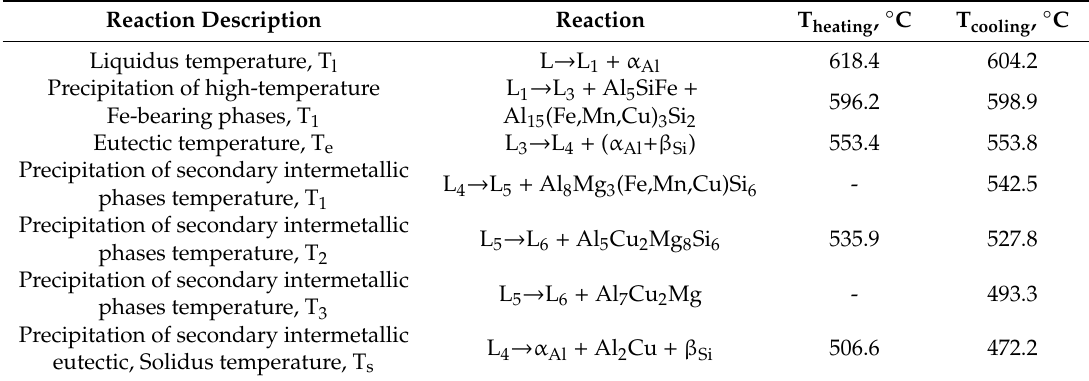
Table 5. Solidification sequence of AlSi7MgCu alloy.